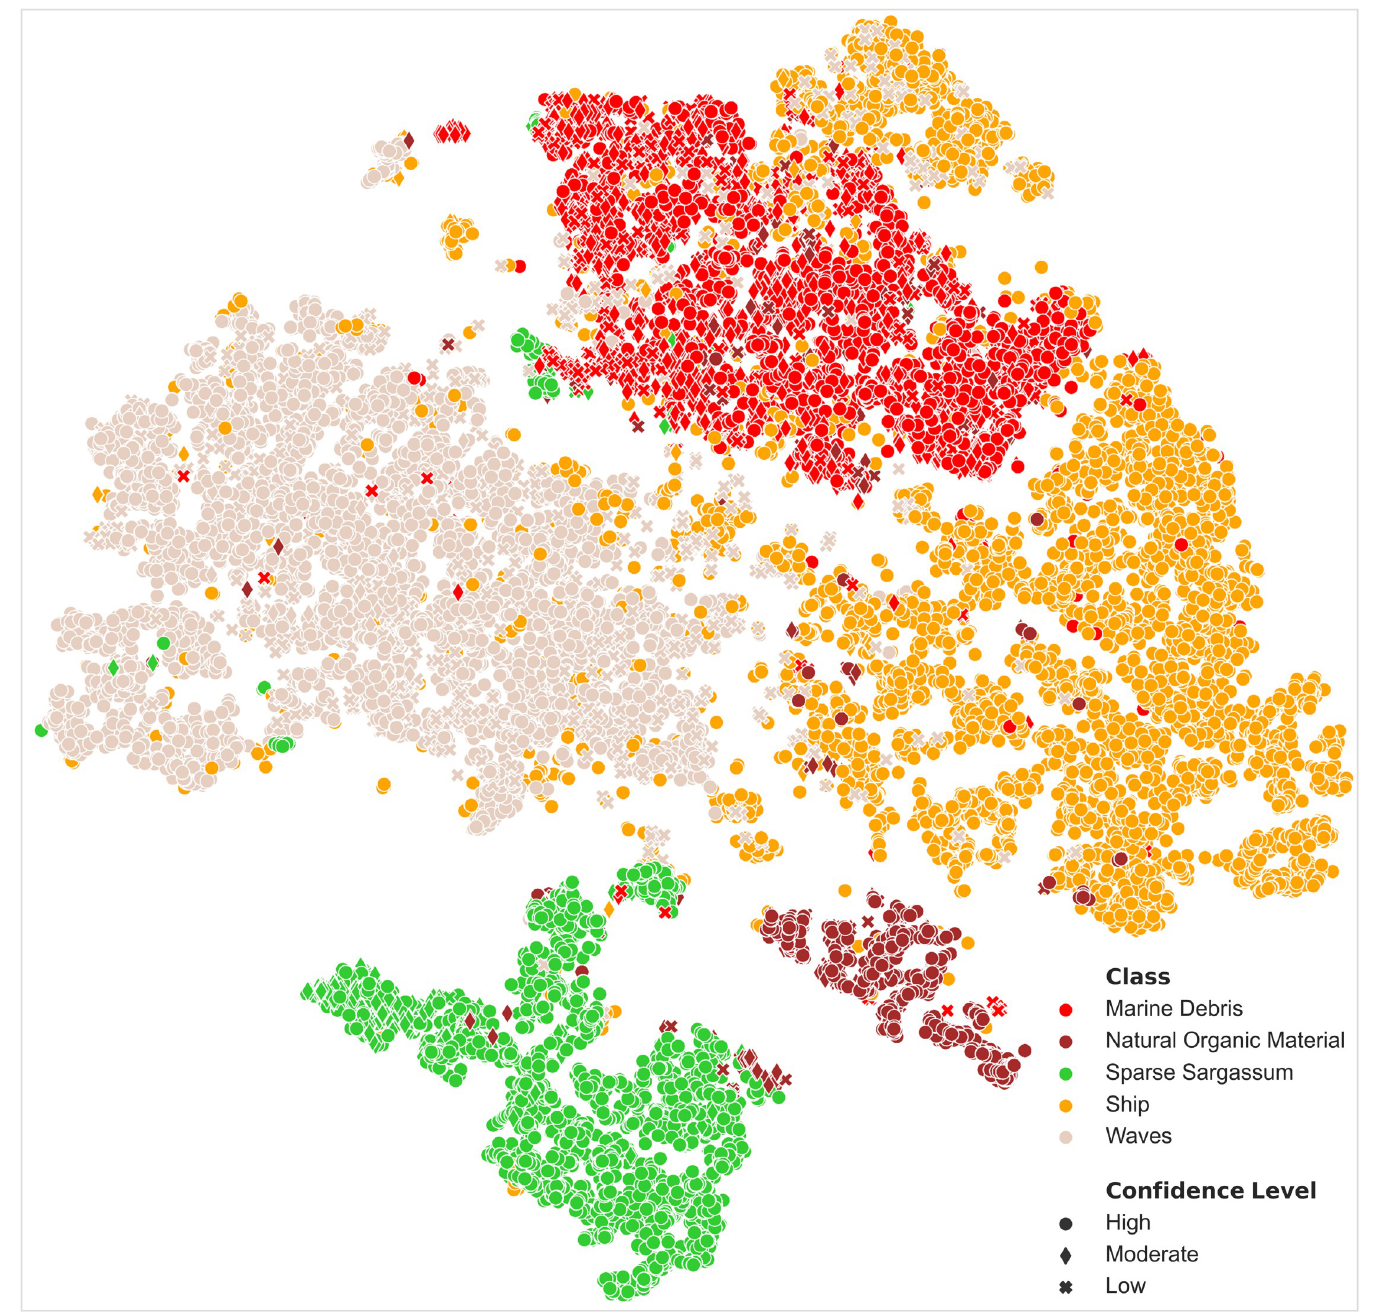
Fig 4. A 2D embedding using T-SNE algorithm with SAM metric for the classes: Marine Debris, Ships, Sparse Sargassum , Natural Organic Material and Waves. Each class is represented with a different color. Different symbols demonstrate the confidence level of annotations. https://doi.org/10.1371/journal.pone.0262247.g004 dataset, we provide only a certain number of indicative cases with the classes mentioned above. The artifact due to the dissimilar S2 band resolutions led to a specific spectral signature primarily recorded on surrounding water pixels of Marine Debris, SpS and Ship . This class was labelled as MixWater , as it corresponds to water, and digitized around annotated Marine